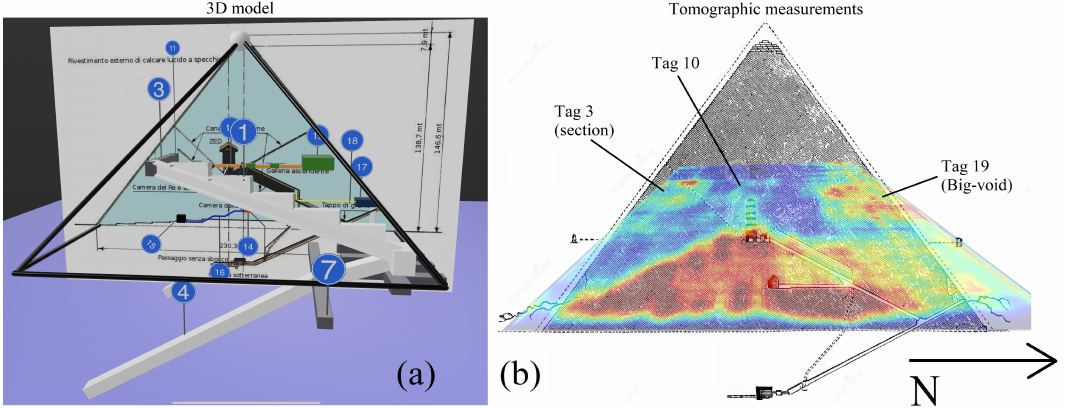
Figure 55. Tags association from tomography to 3D model. ( a ): Three-dimensional (3D) model of Khnum-Khufu. ( b ): Tomographic reconstruction